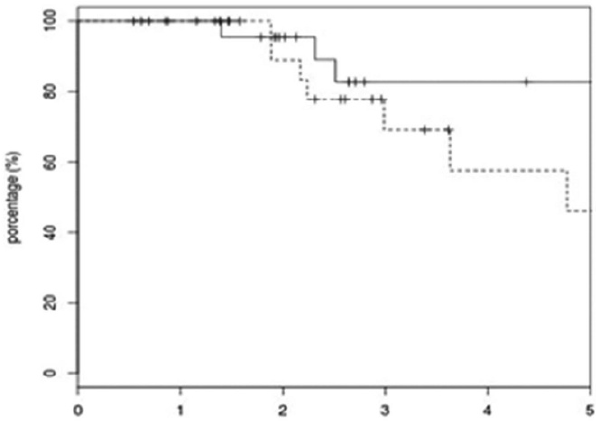
Figure 3 - Kaplan-Meier analysis of 5-year overall survival comparing Pex (---) with Unpex (—). Pex: 46.1% 6 Unpex: 82.7% (